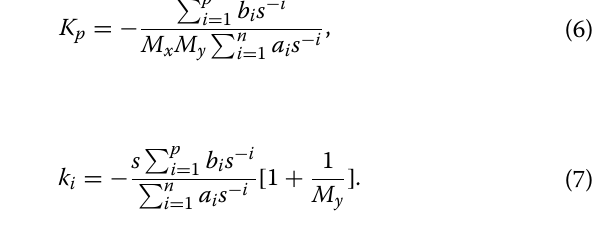
displacement in x -axis, and ment in y -axis. c x and c y are modal damping in x - and y -directions.